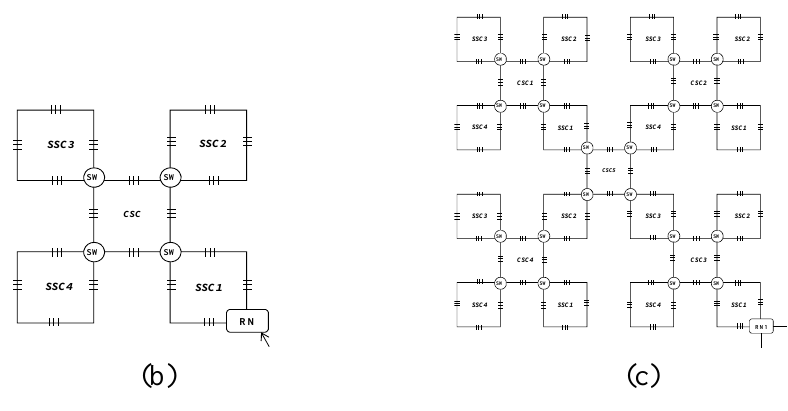
Figure 8. (a) SSC; (b) first extension; (c) second extension.